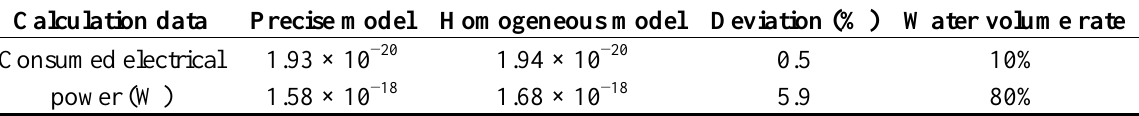
Table 5. Consumed electrical power in the precise model and homogeneous model.